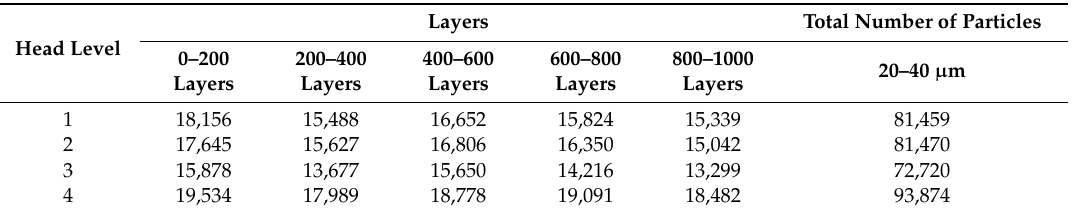
Table 13. Variation in the number of fine particles percolated with the 50% fine particle content (20–40 µ m).